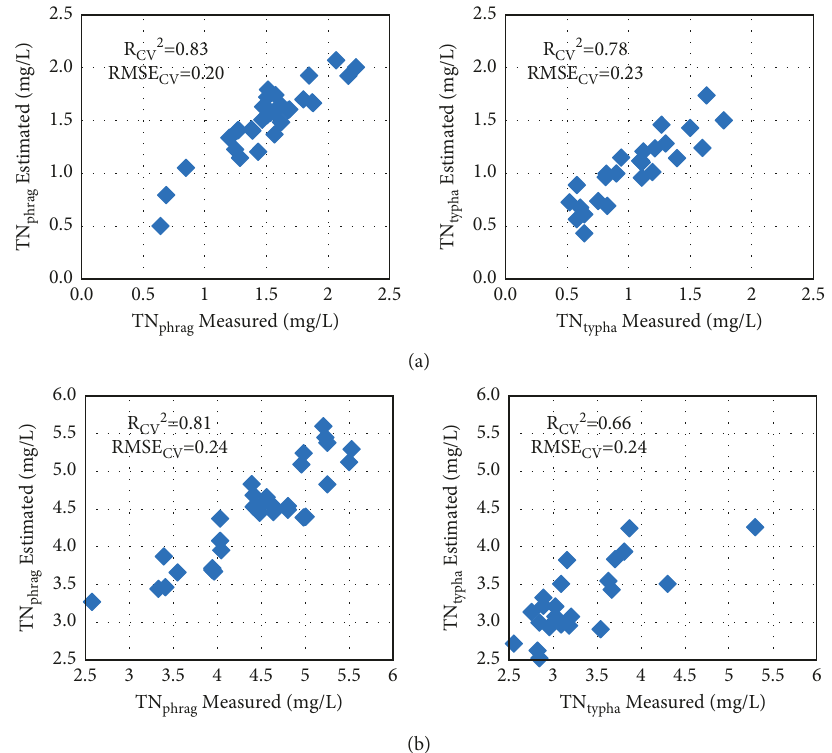
Figure 4: Relationship between measured values and estimated values in cross validation of PLSR model for TN contents in water (a) and TN contents in plants